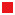
Remaining iprodione (IPR) (%) and biomass by C1 (a), C4 (b), C7 (c), C8 (d), C9 (3), C10 (f) strains at initial IPR concentration of 0, 10, 20, 50 and 100 mg L-1, evaluated during 120 h. (●) IPR 10 mg L-1; (◼) IPR 20 mg L-1; (x) IPR 50 mg L-1; (◆) IPR 100 mg L-1; (▲) Control without IPR. Continuous line: Remaining IPR (%); Dotted line: biomass (g L-1).